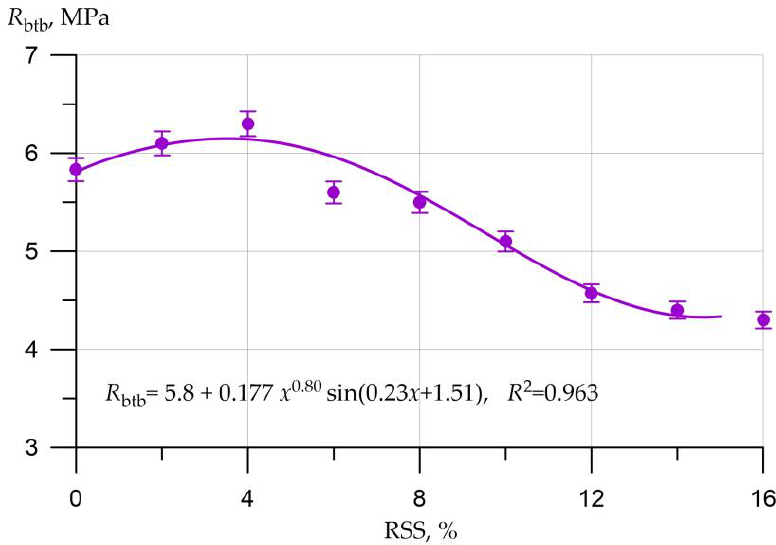
Figure 5. Results of investigational studies of the influence of local replacement of CA with RT seed shells on axial CS b R .